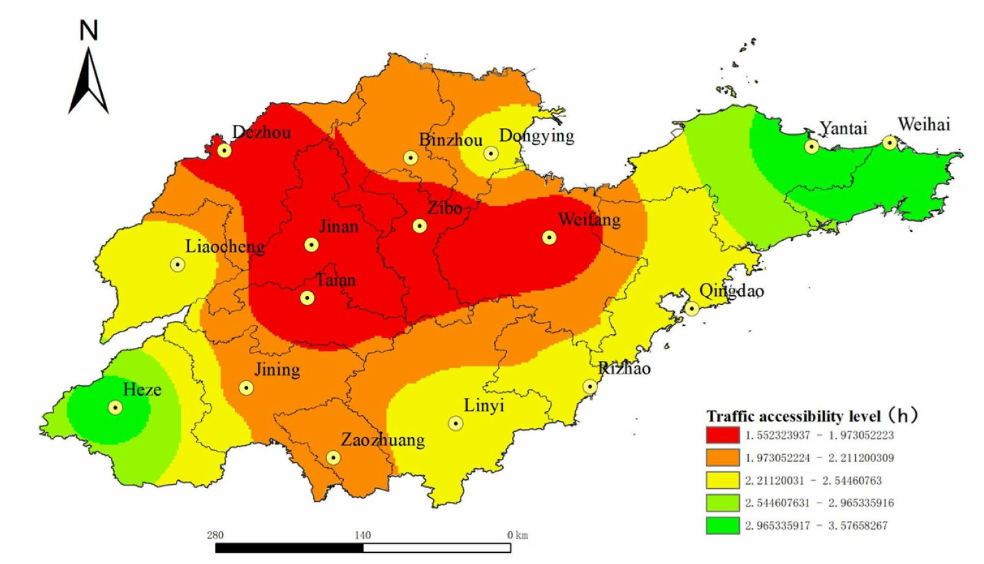
Figure 4. Spatial distribution of land traffic accessibility in Shandong Province, China, in